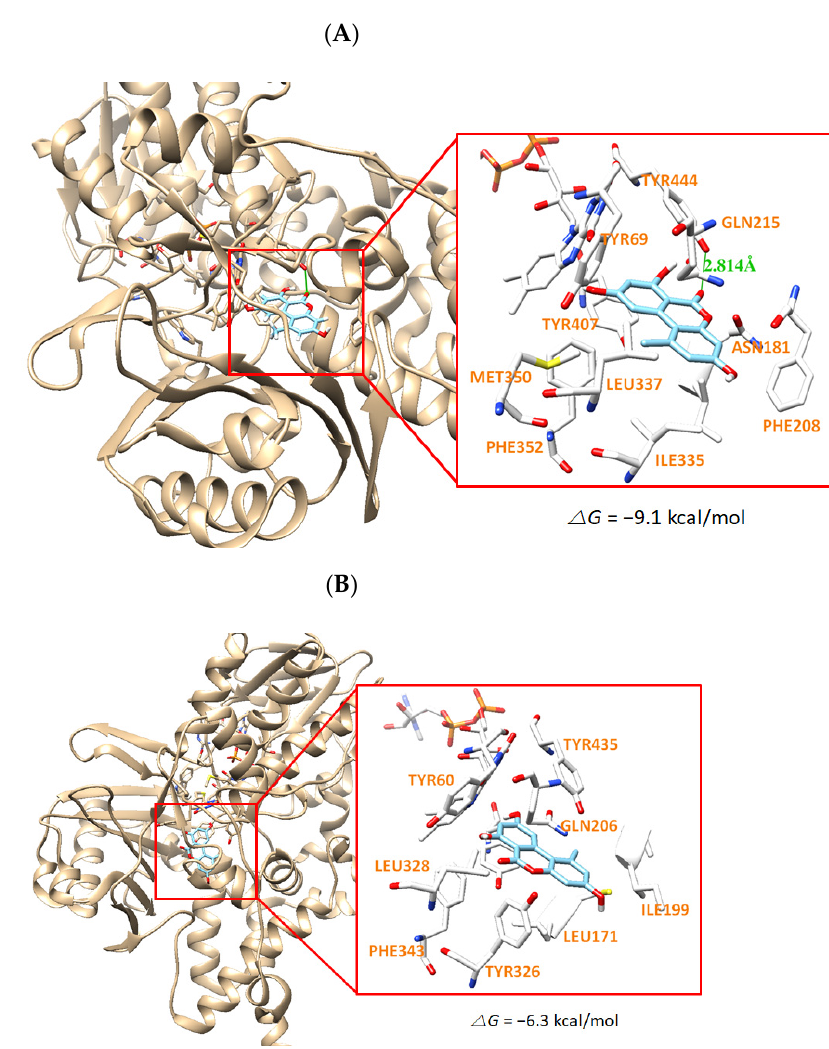
Figure 5. The docking simulation of AT with hMAO-A (2Z5X) ( A ) and hMAO-B (3PO7) ( B ) as determined by the UCSF Chimera. AT interacts through a hydrogen bond with Tyr444 residue of hMAO-A at a distance of 2.814 Å.